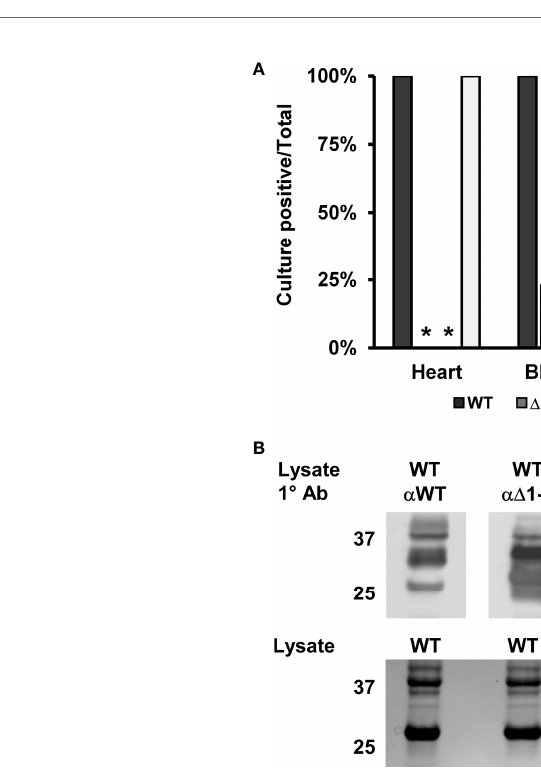
Figure 6C ), in D d07 compared to wild type and D d07 Comp